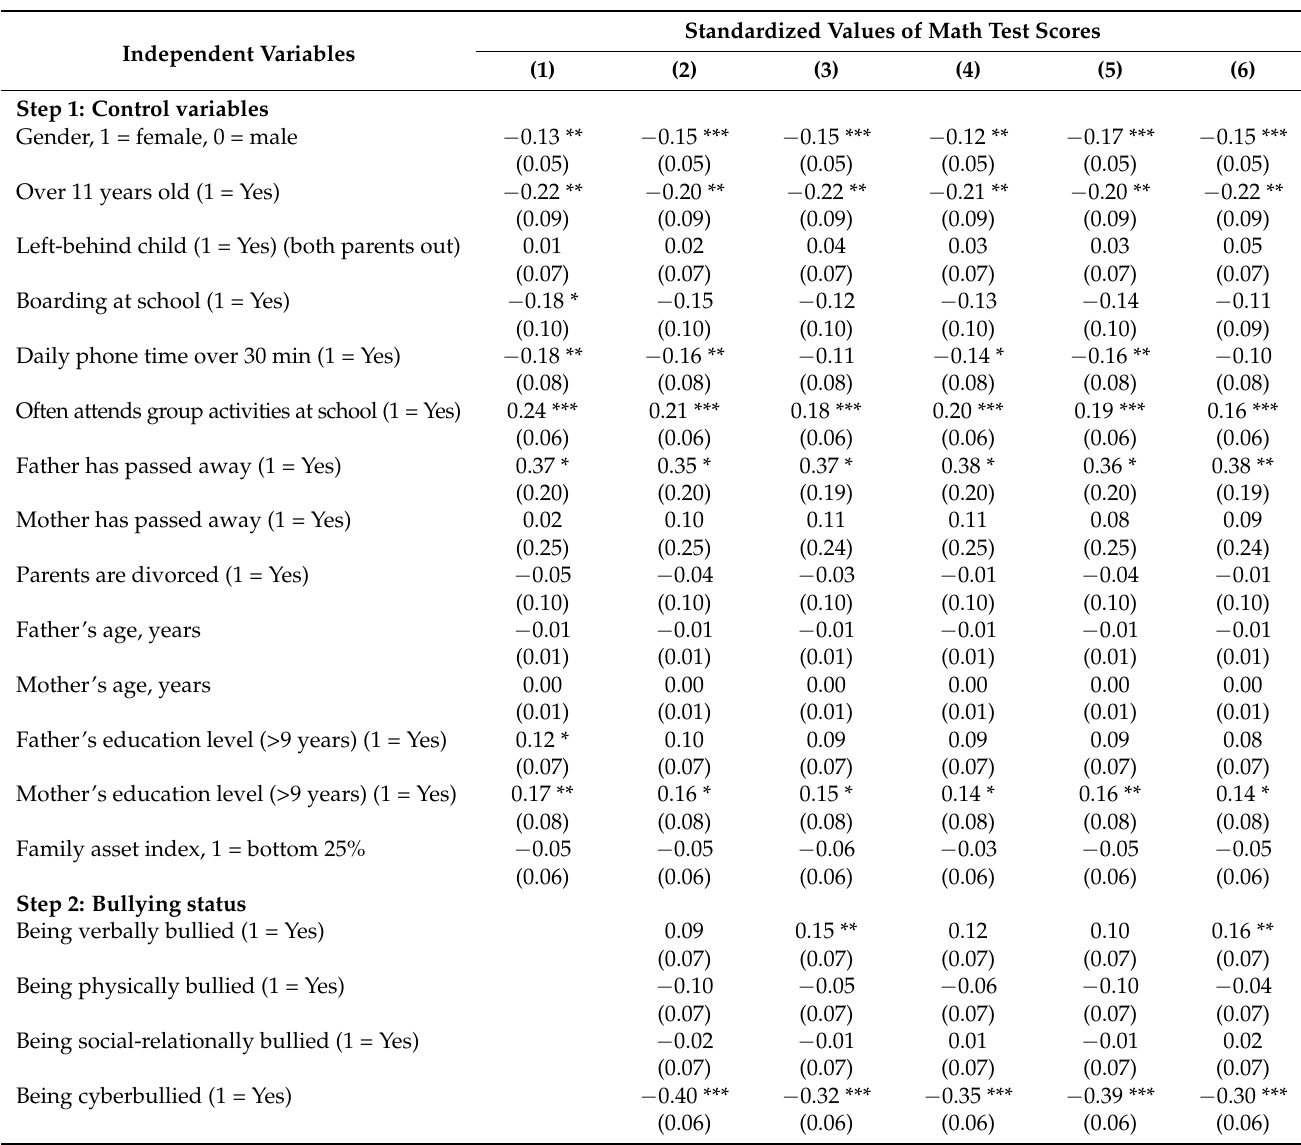
Table 4. Hierarchical regression of SDQ score and academic performance in